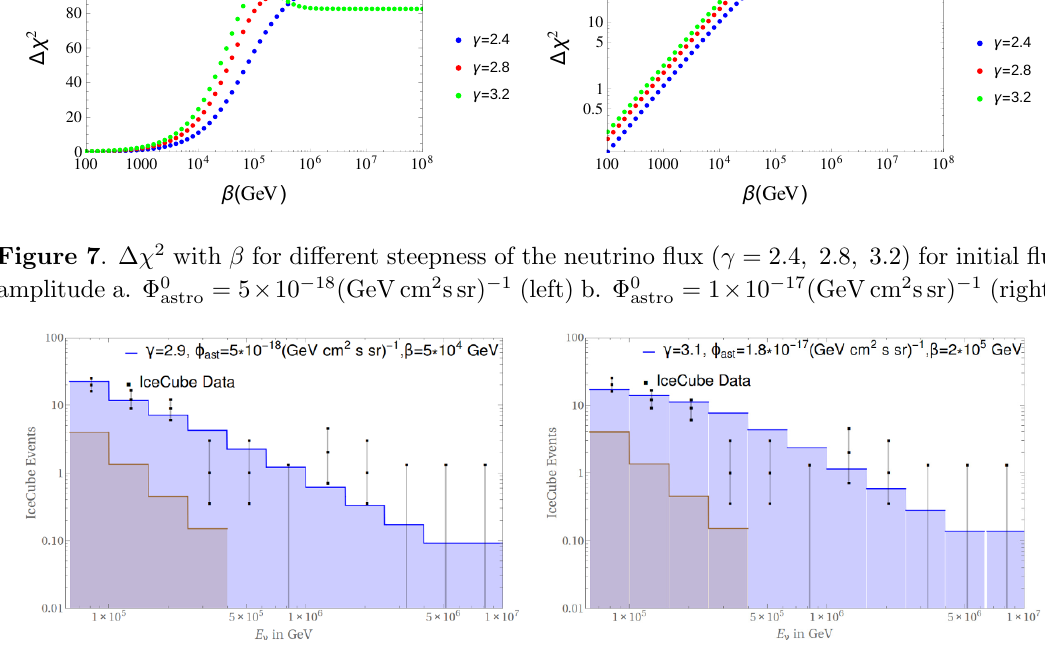
= 8 (cid:2) 10 (cid:0) 17 (GeV cm 2 s sr) (cid:0) 1 , astro